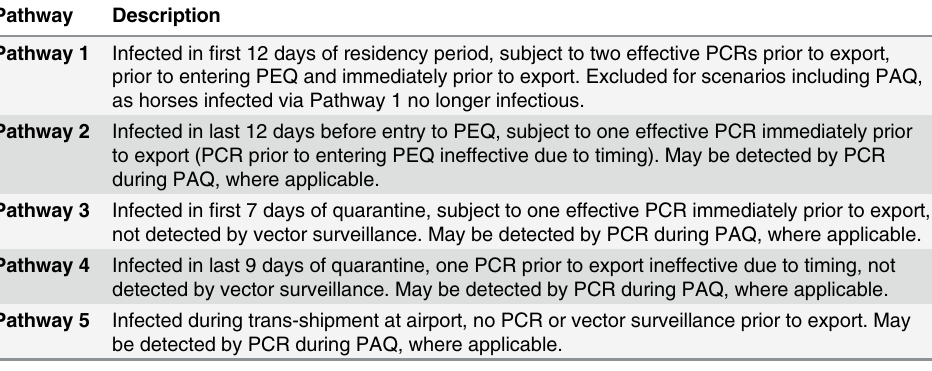
Table 2. Potential pathways for infection of horses for export of AHSV from South Africa.